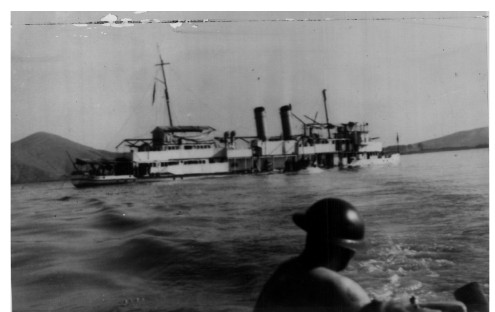
Figure 2. Sinking of the SS Panay. Source: The Denver Post/ Getty